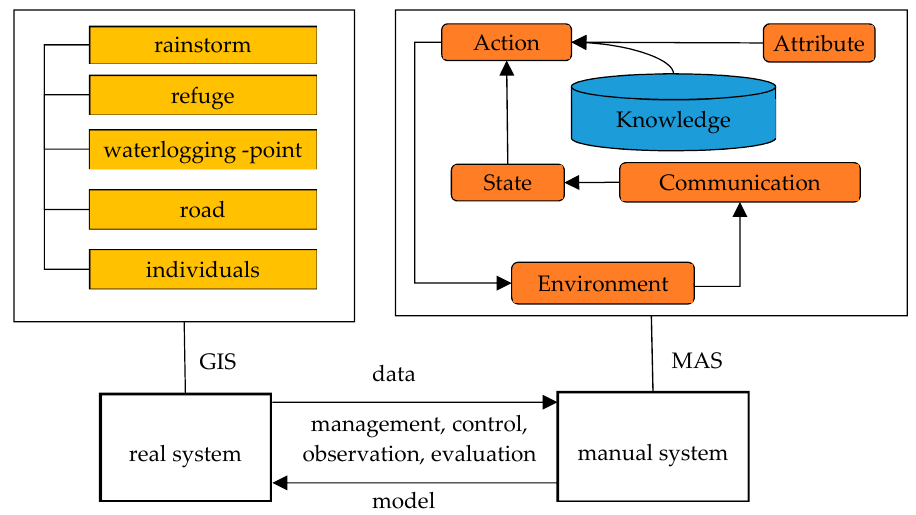
Figure 2. Urban Rainstorm Escape Simulation Platform.